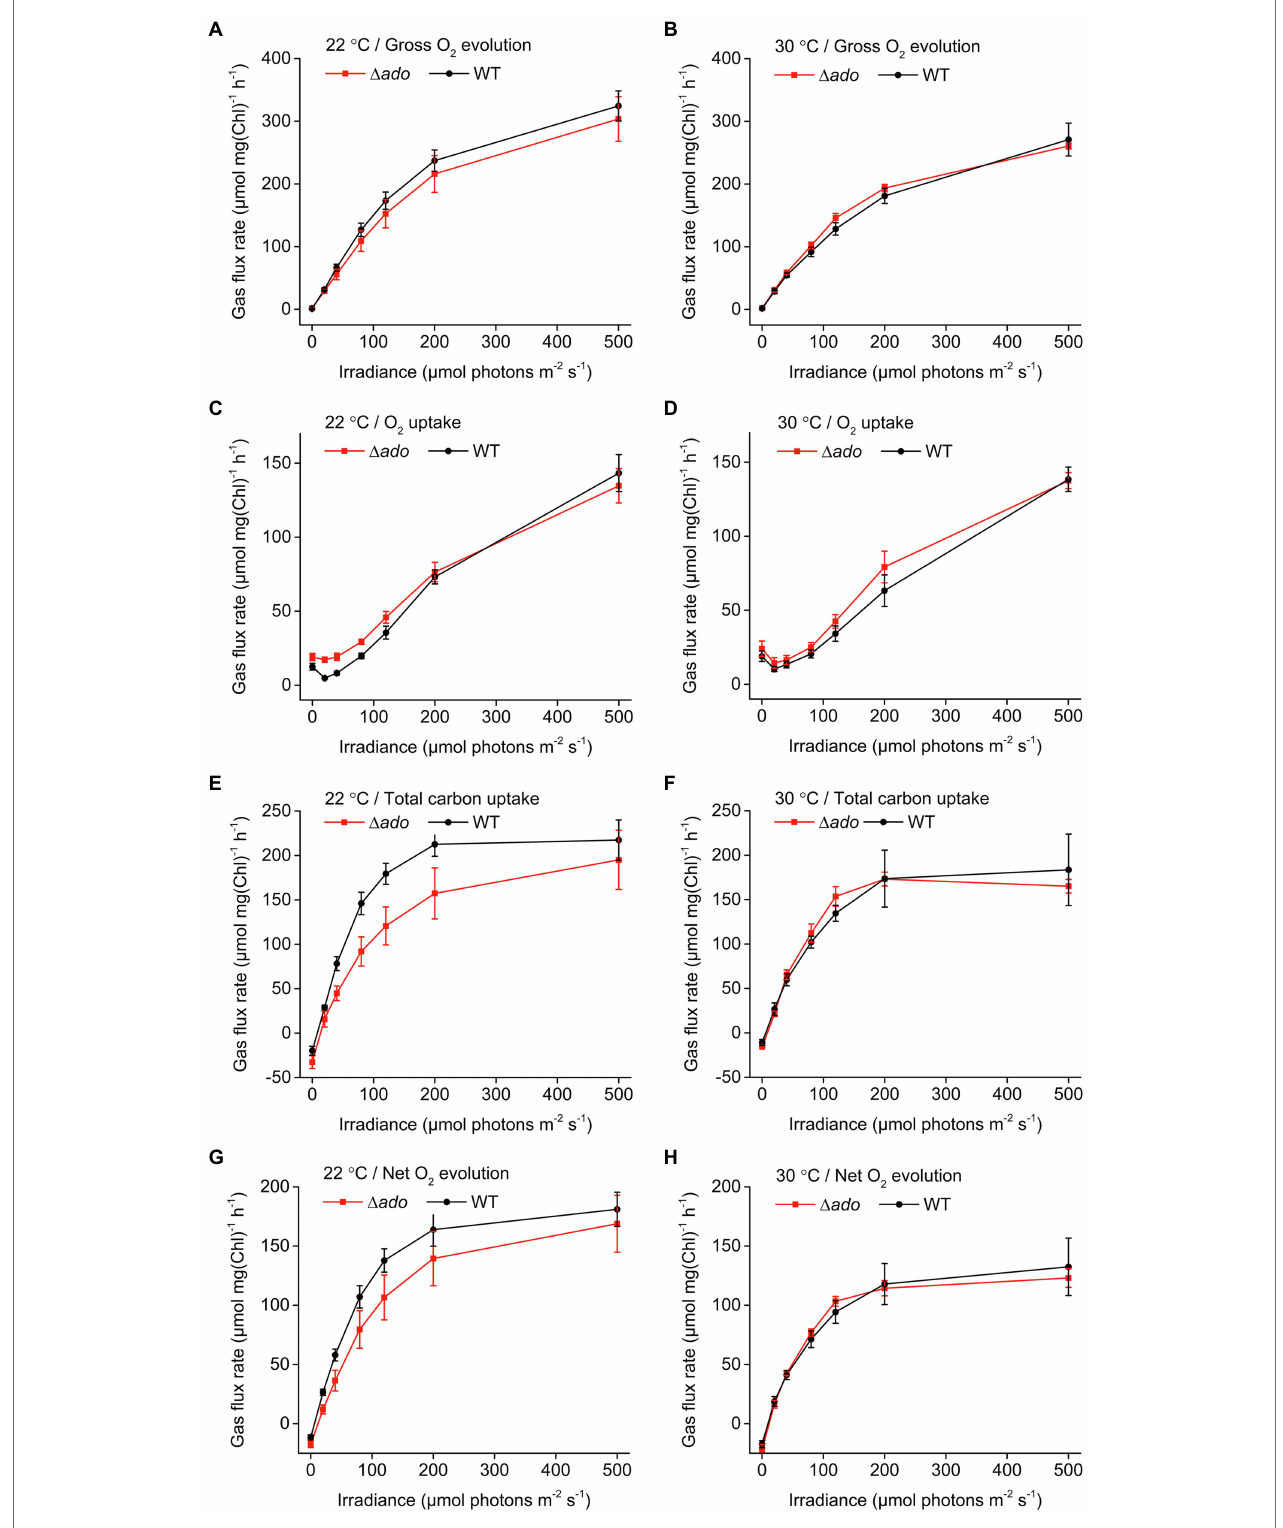
FIGURE 6 | Comparison of cellular gas fluxes between Synechocystis sp. PCC 6803 WT and Δ ado measured by Membrane Inlet Mass Spectrometry (MIMS): (A,B) gross O 2 evolution, (C,D) O 2 uptake, (E,F) total carbon uptake, and (G,H) net O 2 evolution. The cells were cultivated for 4 days at 22 ° C or at 30 ° C as indicated, and each sample was adjusted to Chl a = 15 μ g ml − 1 for analysis. The averages and standard deviations were calculated based on three independently conducted